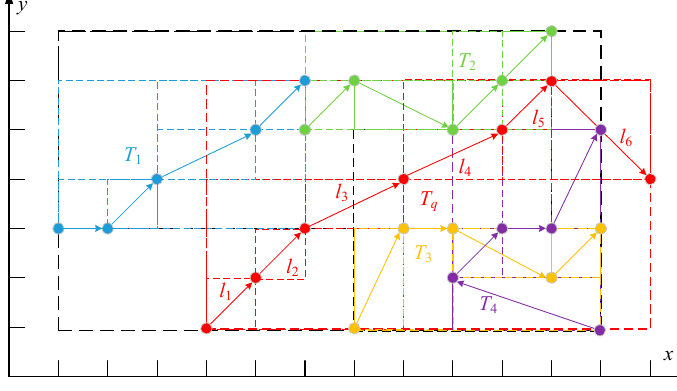
Figure 7. Example of the pruning process of THC query.